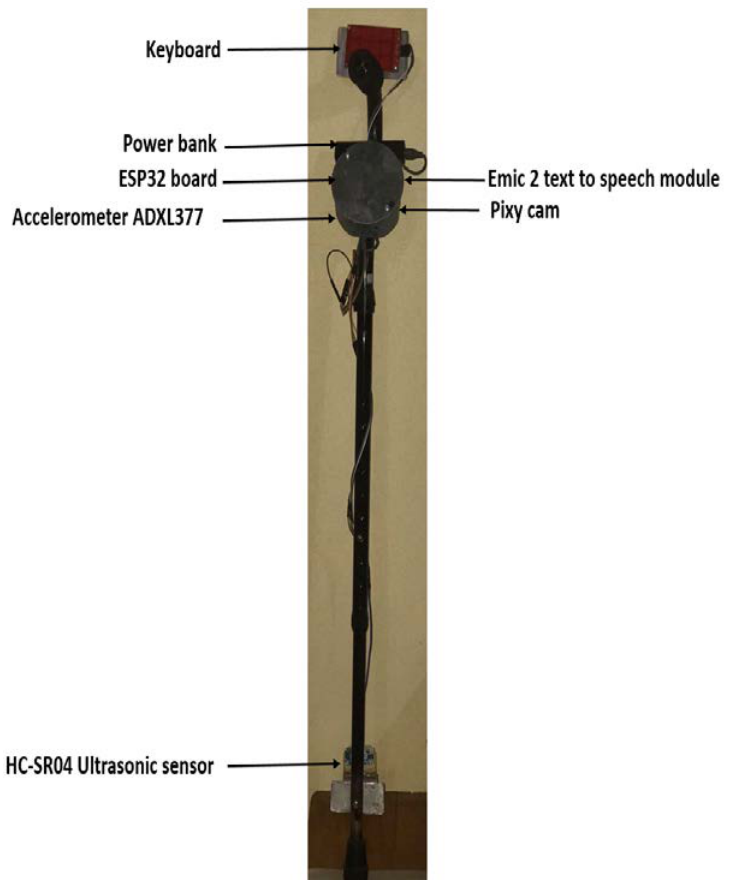
Figure 4. The components of the Smart Cane.